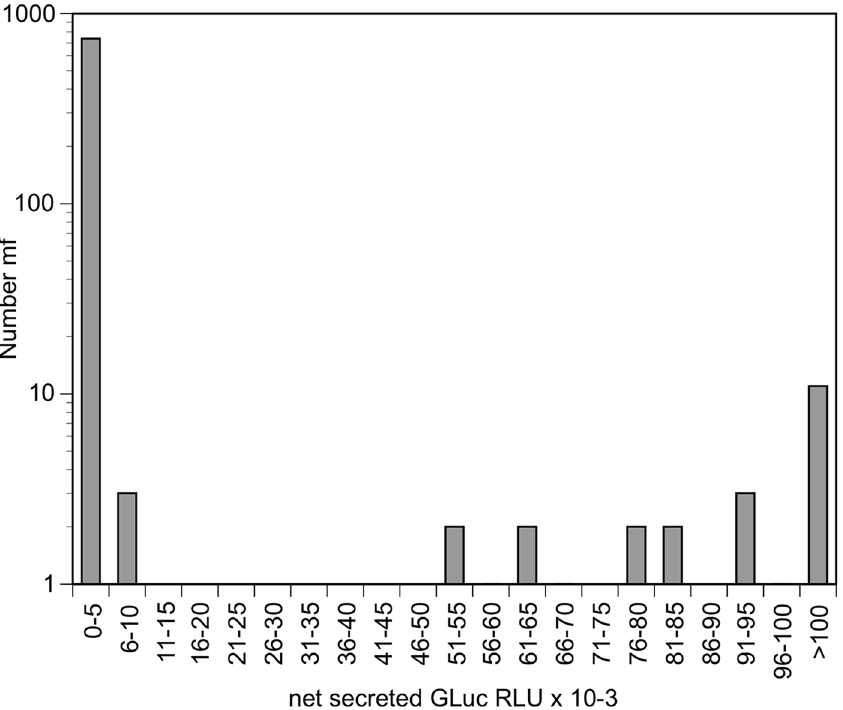
Fig 3. Secreted GLuc activity in cultures of individual microfilaria derived from adult parasites transfected in the L3-L4 stage. Bars represent the number of individual microfilariae producing secreted GLuc activity in the range shown. Note that the y-axis is